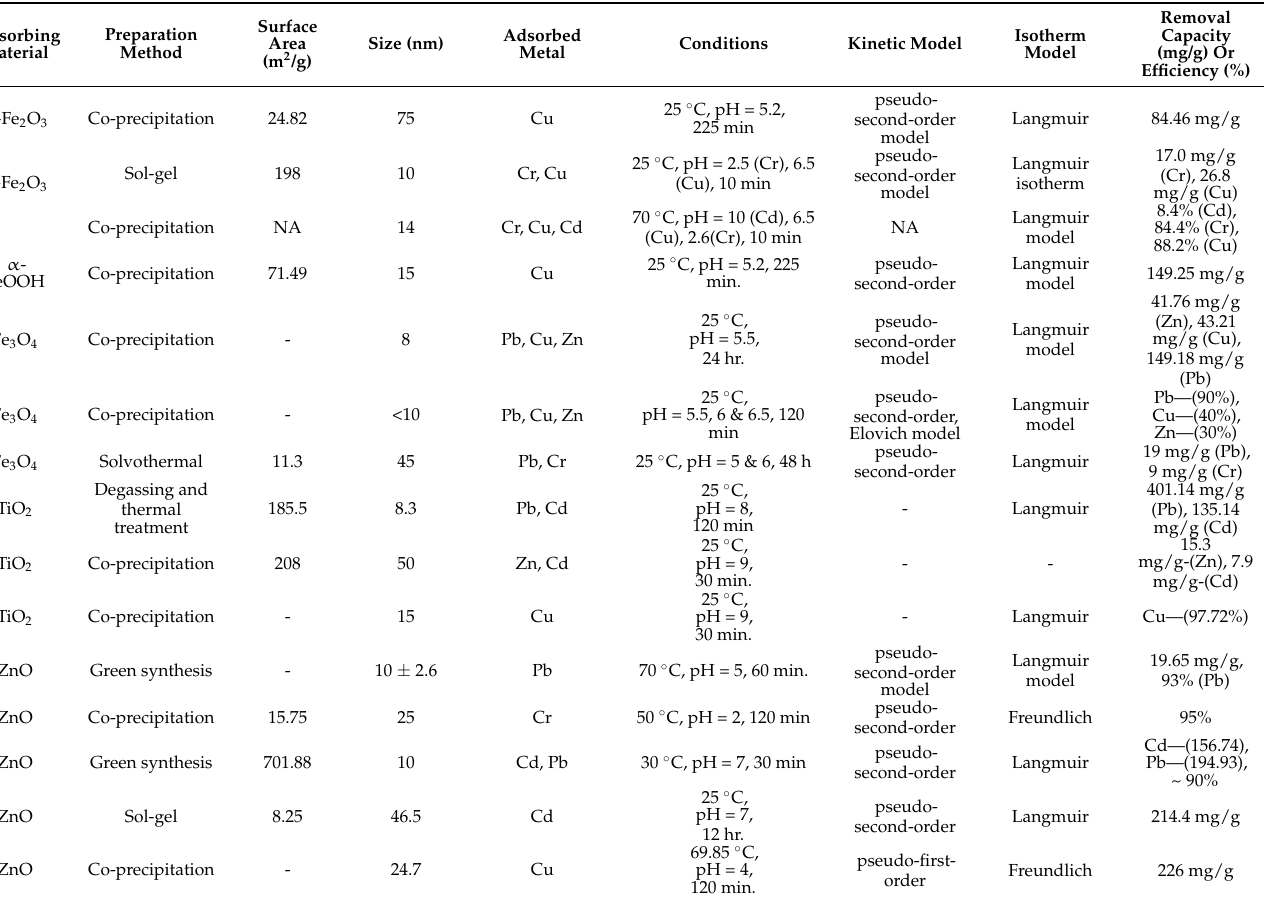
Table 5. The synthesized metal oxide nanoparticles are applied for the adsorptive removal of metal ions in an aqueous